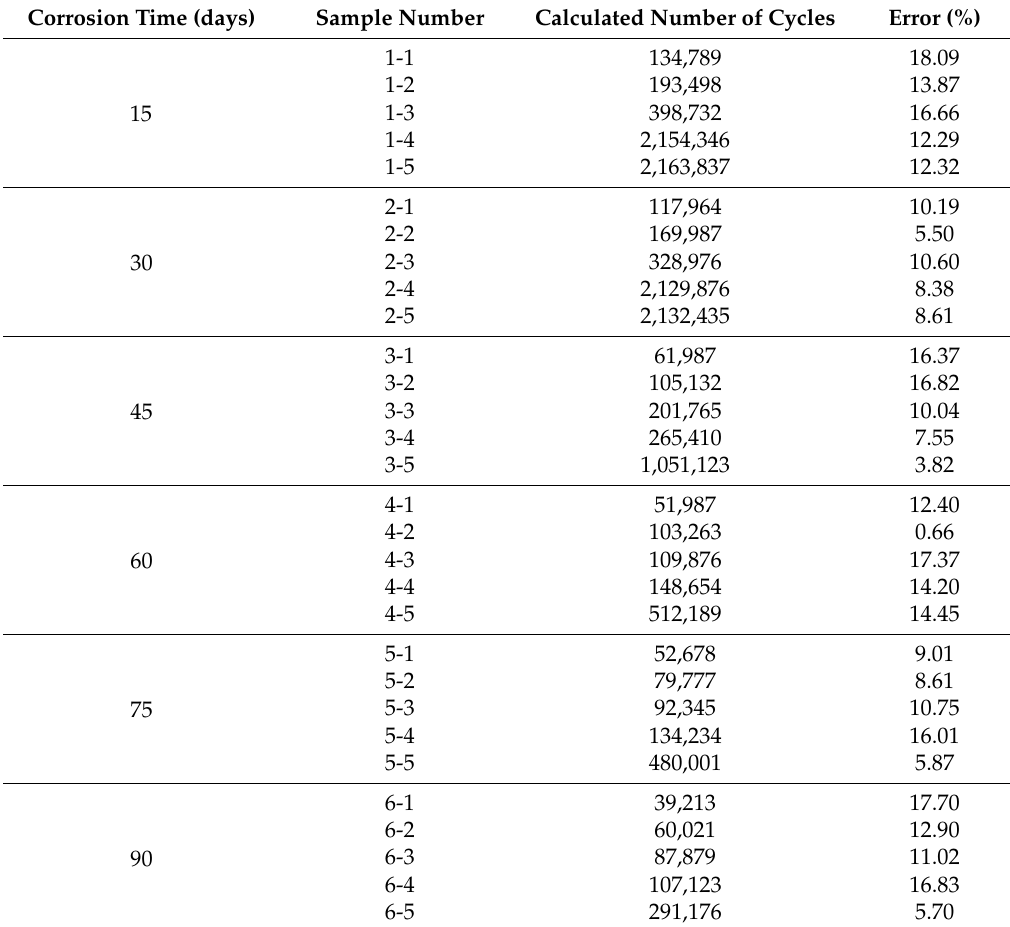
Table 4. Comparison results of fatigue